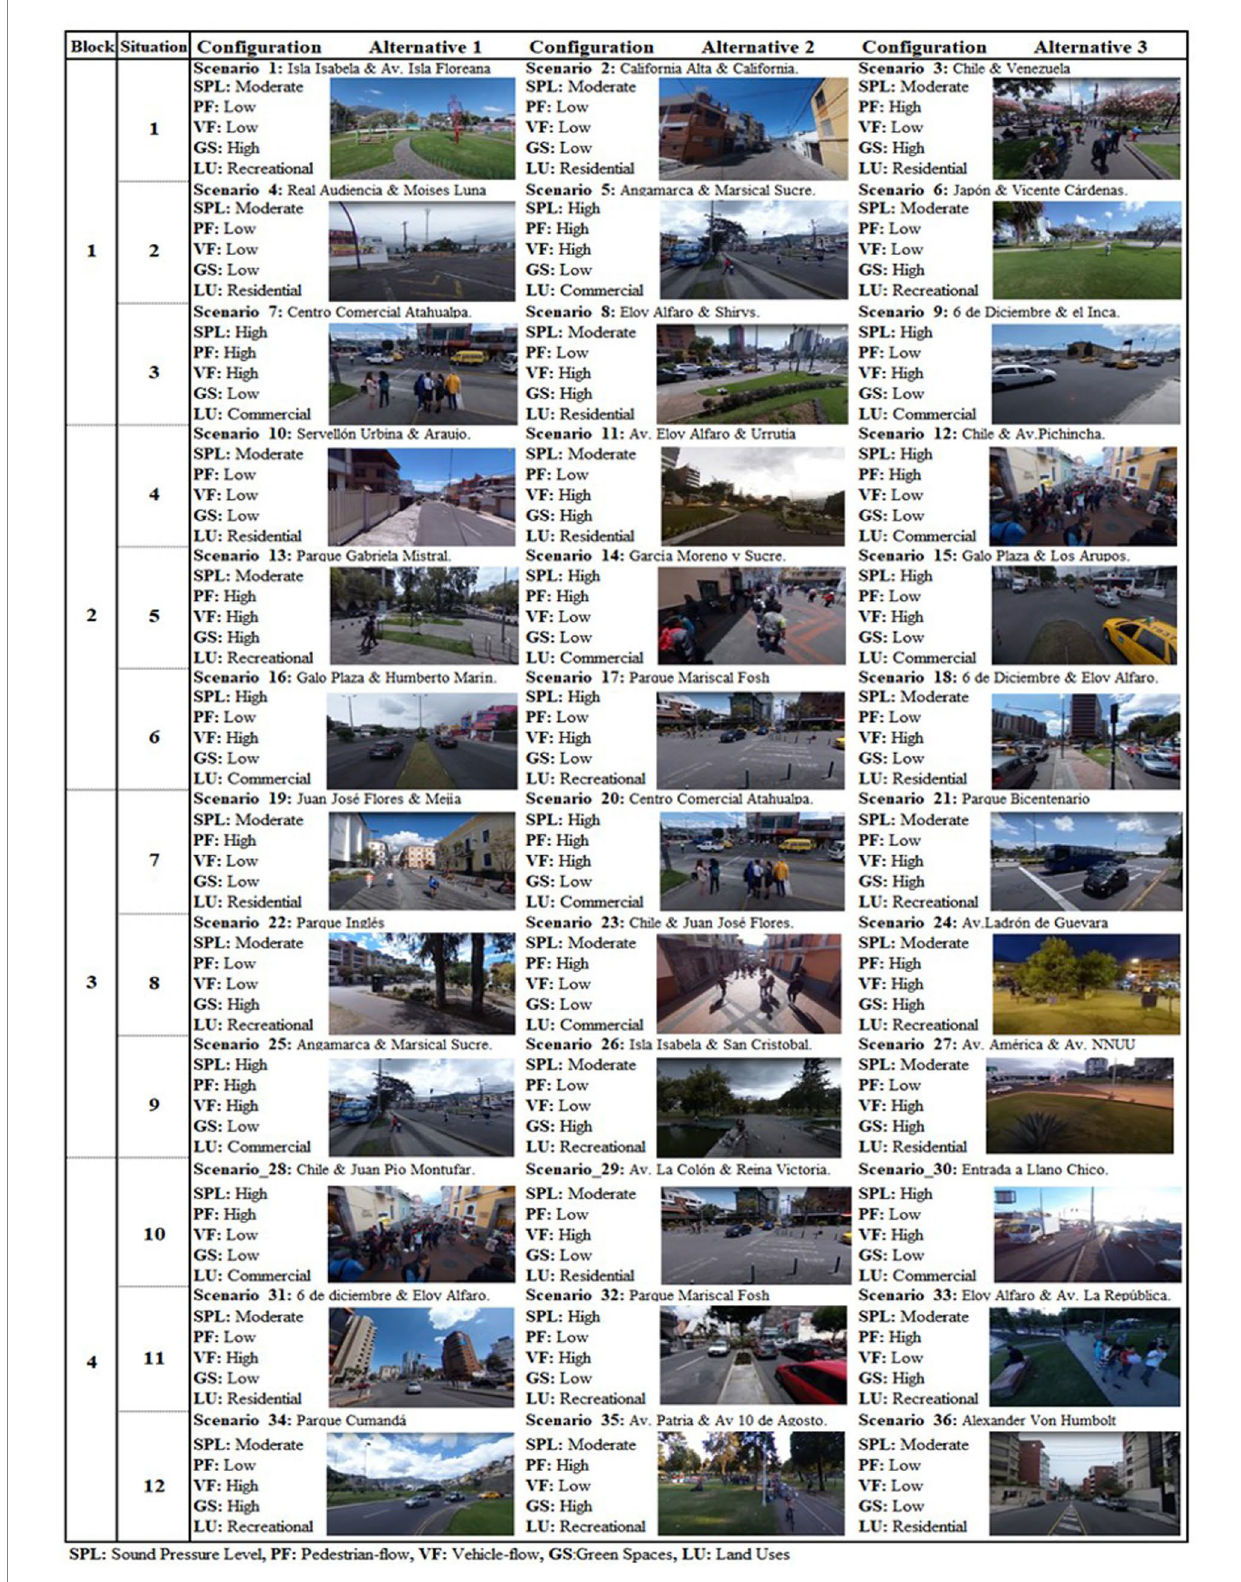
FIGURE 1 Residential environment